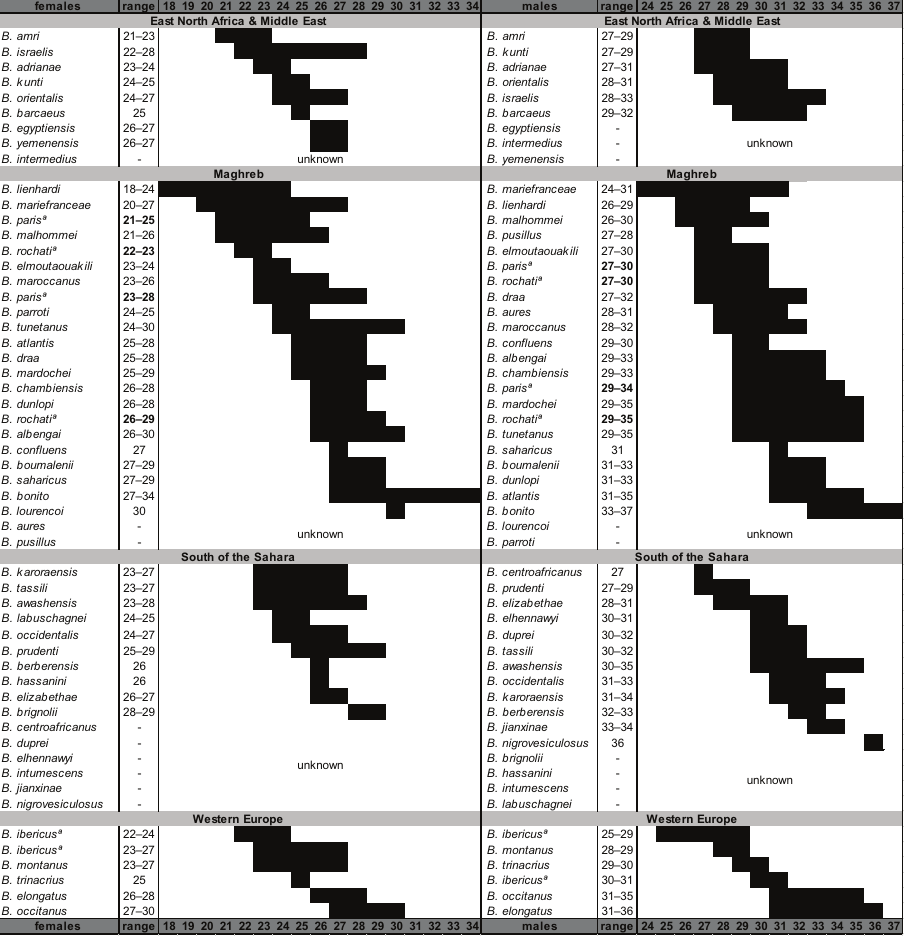
Figure 10. Graphical representation of the variation in pectinal teeth number of Buthus species arranged by geographical areas to facilitate comparison. All known Buthus species are represented, although female and male are ordered independently, from smaller to largest. ª Species for which the bibliographic ranges are